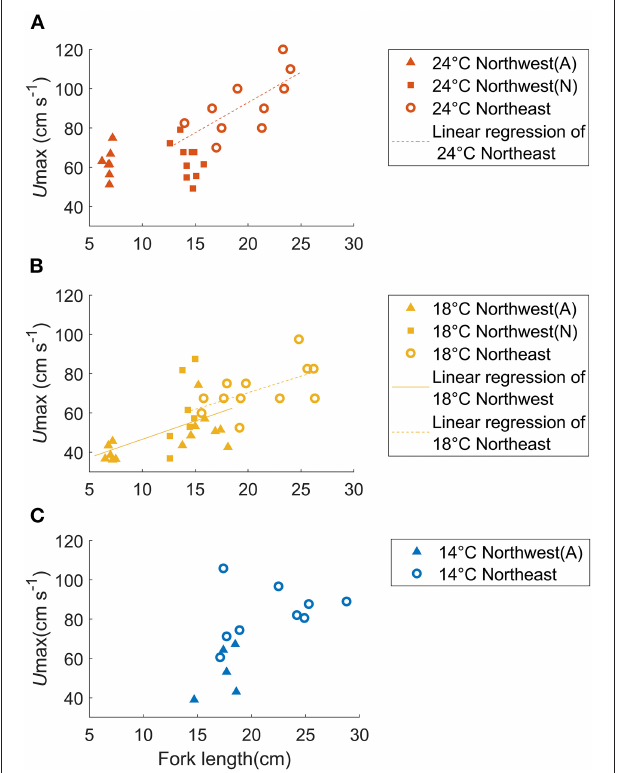
FIGURE 3 | Relationship between fish mass and U max for aquaculture-reared (A, solid triangles) and wild-caught (W, solid squares) chub mackerel from the Northwest stock in comparison to individuals of the Northeast stock (open circles) compared over three temperatures: (A) 24 ◦ C, (B) 18 ◦ C, and (C) 14 ◦ C. The linear regressions of U max as a function of fish size are shown as solid (Northwest stock) and dashed (Northeast stock) lines. At 18 ◦ C, U max = 1.864 FL + 27.94 ( r 2 = 0.252, p < 0.05) for the Northwest stock and U max = 1.682 FL + 36.64, ( r 2 = 0.333, p < 0.05) for the Northeast stock (Dickson et al., 2002). The slopes of these two regression lines were not significantly different.